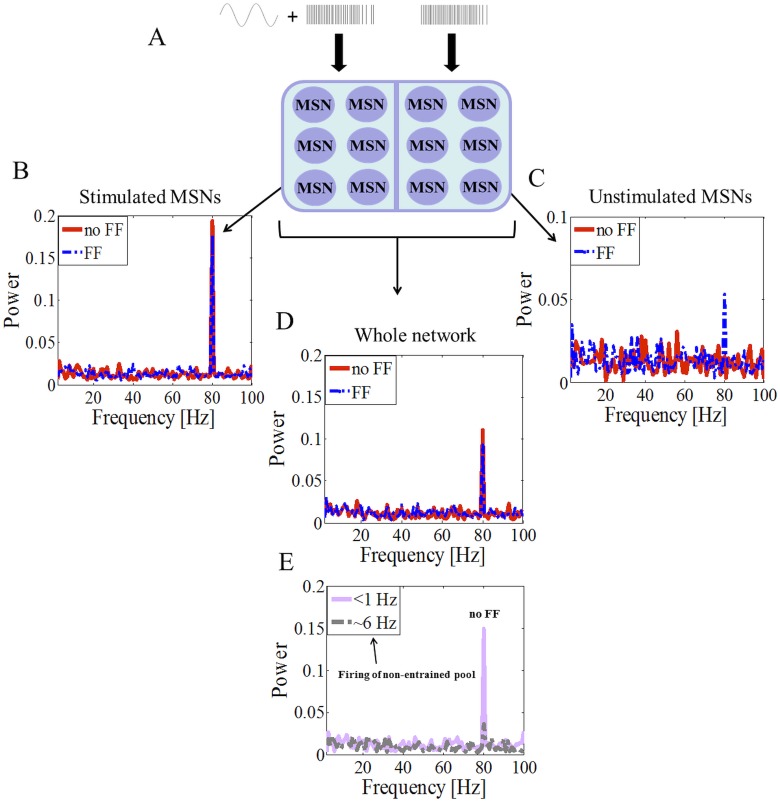
Interplay between oscillatory inputs into MSNs and FSIs.(A) Schematic of striatum network. The stimulated MSNs received sinusoidal current inputs in addition to the Poisson type background spiking input. The unstimulated-MSNs only received the Poisson type spiking inputs. (B) The spectral analysis of the population activity of MSNs, without (red trace) and with (blue trace) feedforward inhibition, stimulated by a sinusoidal currents input at 80 Hz. (C) Same as in B but for unstimulated MSNs. (D) The spectral analysis of the whole MSN population. (E) In the absence of FSI stimulation, oscillations in the whole MSN network could be destabilized by the increase in the average firing of unstimulated MSNs.